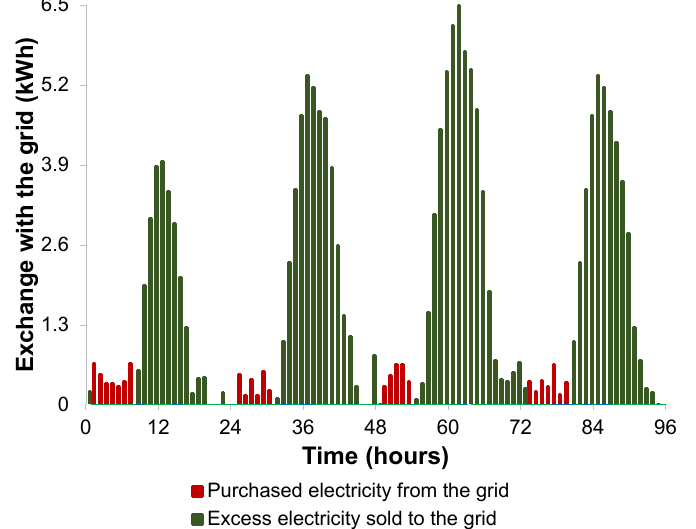
Figure 6. Evolution over the 4-day time horizon of the electricity import and export for household i1.